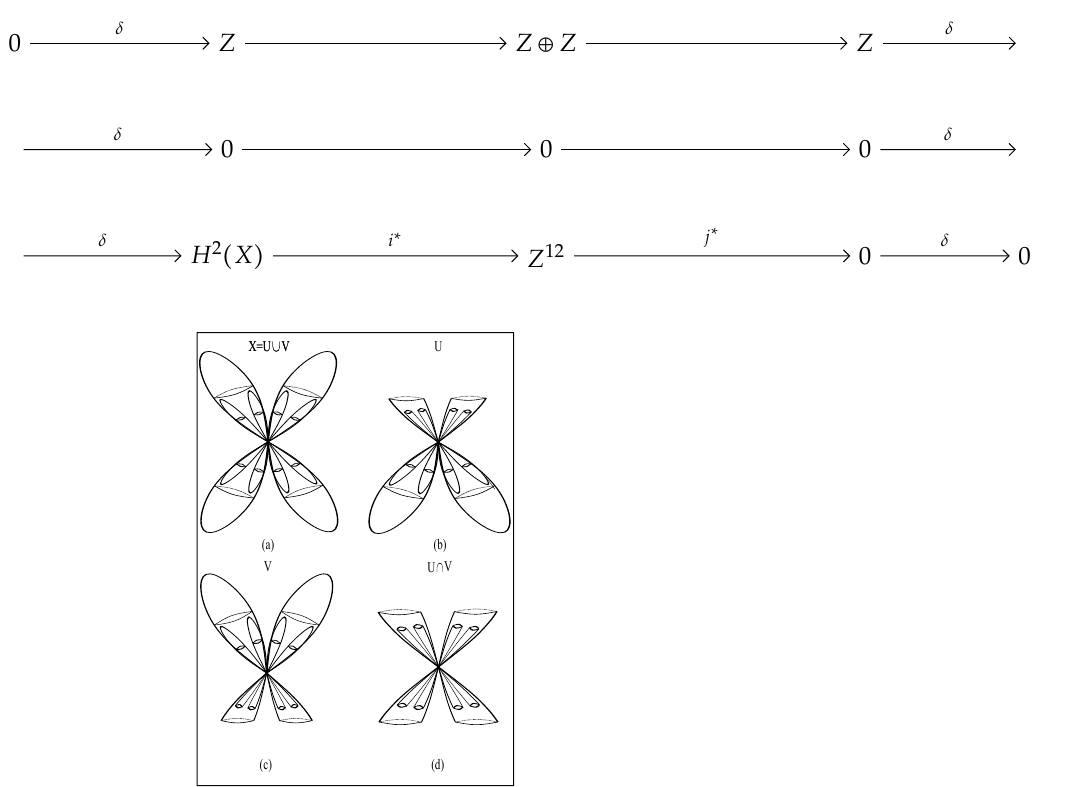
Figure A4. Open sets U and V for computing the cohomology group H 2 ( X ) . We see that H 2 ( X ) = Z 12 .